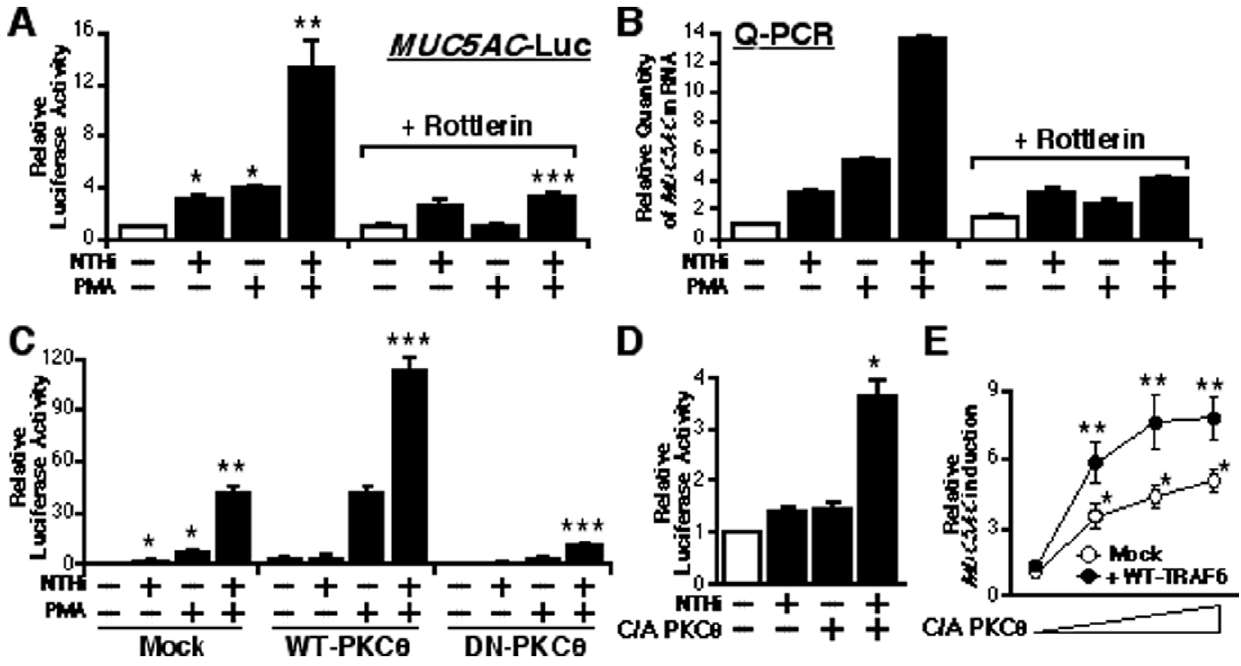
Figure 6. TLR-TRAF6-dependent synergistic MUC5AC induction by NTHi and PMA is mediated by PKC h . ( A ) Rottlerin, a specific PKC TM / h inhibitor, blocked the synergistic induction of MUC5AC transcription by NTHi and PMA in human epithelial cells, as assessed by MUC5AC-dependent promoter Luciferase assay. Cells were pre-treated with 20 m M of Rottlerin or vehicle control, and treated with NTHi with or without PMA. Relative luciferase activity of MUC5AC was measured from the cell lysate. Values are the means 6 S.D. (n=3). *p , 0.05 vs. control; **p , 0.05 vs. NTHi alone; *** p , 0.05 vs. NTHi with PMA in vehicle treated cells. ( B ) The synergistic induction of MUC5AC expression was also attenuated by Rottlerin at the mRNA level, as assessed by performing Q-PCR. Cells were pre-treated with 20 m M of Rottlerin or vehicle control, and treated with NTHi with or without PMA. mRNA expression level of MUC5AC was measured by Q-PCR. ( C ) Co-expressing WT-PKC h enhanced, whereas DN-PKC h inhibited, the synergistic induction of MUC5AC transcription by NTHi and PMA. Cells were transfected with 0.3 m g of WT- PKC h , 0.6 m g of DN PKC h , or control vector, and treated with NTHi with or without PMA. Relative luciferase activity of MUC5AC was measured from the cell lysate. Values are the means 6 S.D. (n=3). *p , 0.05 vs. control; **p , 0.05 vs. NTHi alone; *** p , 0.05 vs. NTHi with PMA in control vector transfected cells. ( D ) C/A-PKC-induced MUC5AC expression was synergistically enhanced by NTHi in human epithelial cells. Cells were transfeced with 0.3 m g of C/A PKC h or control vecttor, and treated with NTHi. Relative luciferase activity of MUC5AC was measured from the cell lysate. Values are the means 6 S.D. (n=3). *p , 0.05 vs. NTHi alone. ( E ) C/A-PKC h synergized with WT-TRAF6 to induce MUC5AC expression in a dose-dependent manner. Cells were transfected with 0.1, 0.3, or 0.6 m g of C/A PKC h with or without 0.3 m g of WT-TRAF6. mRNA expression level of MUC5AC was measured by Q-PCR. Values are the means 6 S.D. (n=3). *p , 0.05 vs. control; **p , 0.05 vs. C/A PKC h transfected cells. The data shown are representative of three independent experiments. 2 , absence of; + , presence of; NTHi, nontypeable Haemophilus influenzae ; WT, wild-type; DN, dominant negative; C/A, constitutively active